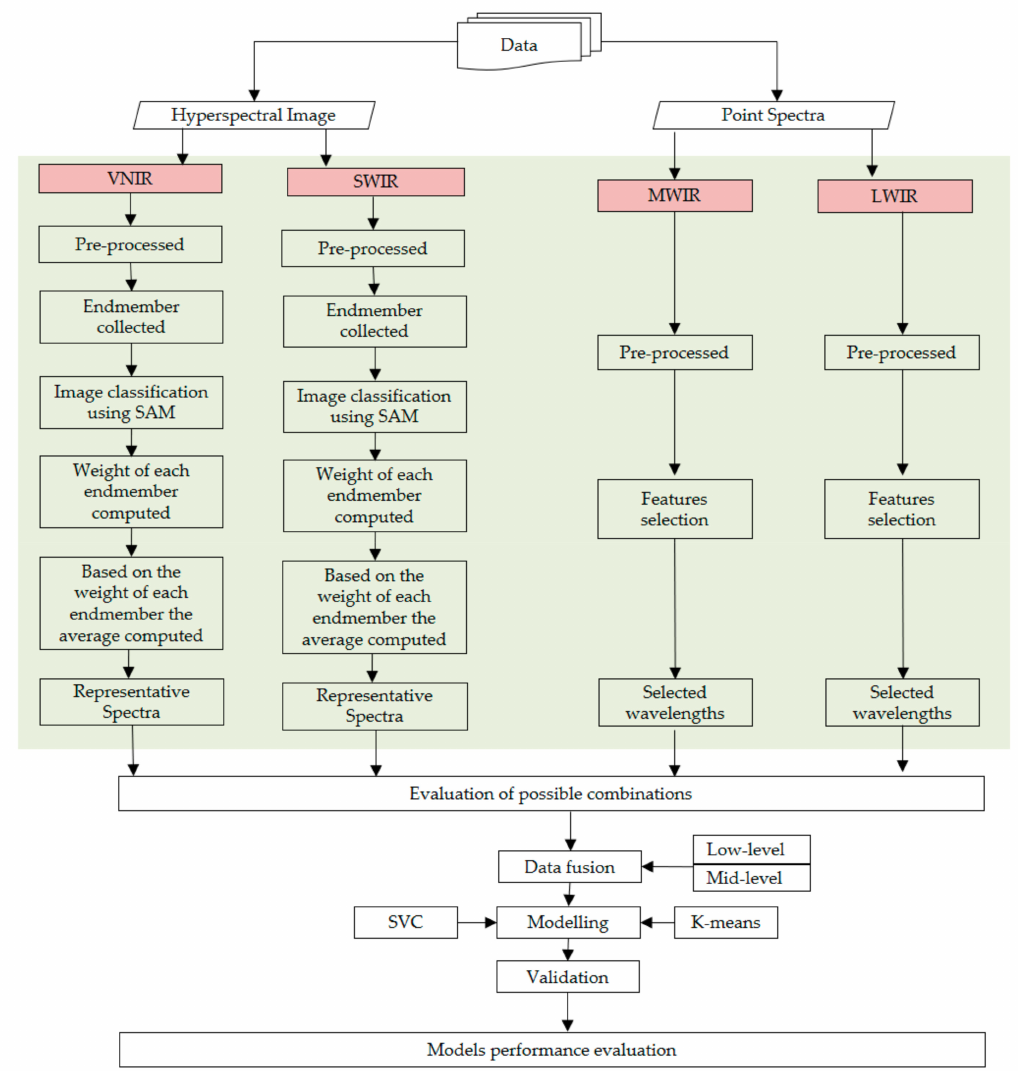
Figure 2. Workflow diagram showing the steps for the developed methodological approach in this